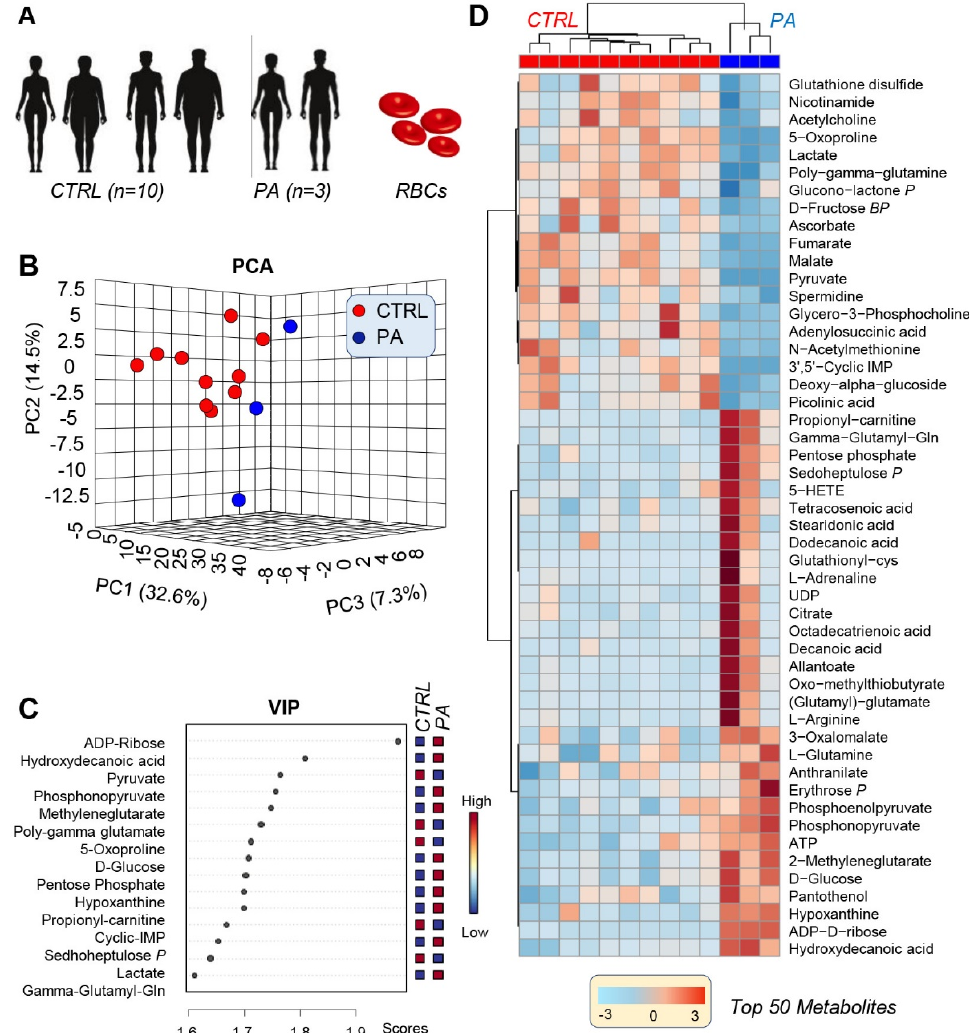
Figure 1. Multivariate analyses show a distinct metabolic signature of PA RBCs. ( A ) Untargeted metabolomics analyses were carried out on RBC samples from 3 PA patients and 10 unaffected CTL patients using UHPLC-MS. ( B ) A principal component analysis (PCA) indicated that PA samples were metabolically distinct when compared to CTL samples. ( C ) The variable importance in projection (VIP) values from a partial least square discriminant analysis (PLS-DA) highlighted the metabolites that contributed most to the clustering pattern, notably metabolites of glucose metabolism, fatty acid metabolism, and purine metabolism. ( D ) A hierarchal clustering analysis (HCA) of the top 50 significant metabolites by ANOVA revealed a broader picture of the metabolic alterations between PA and CTL